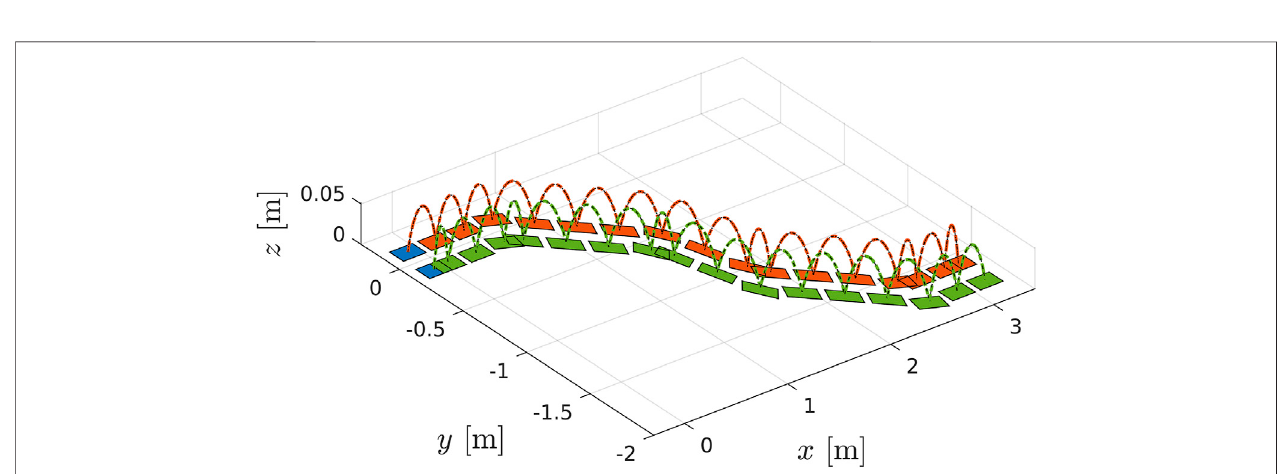
FIGURE 11 | Detail of the swinging foot trajectory with a 0.05 m step